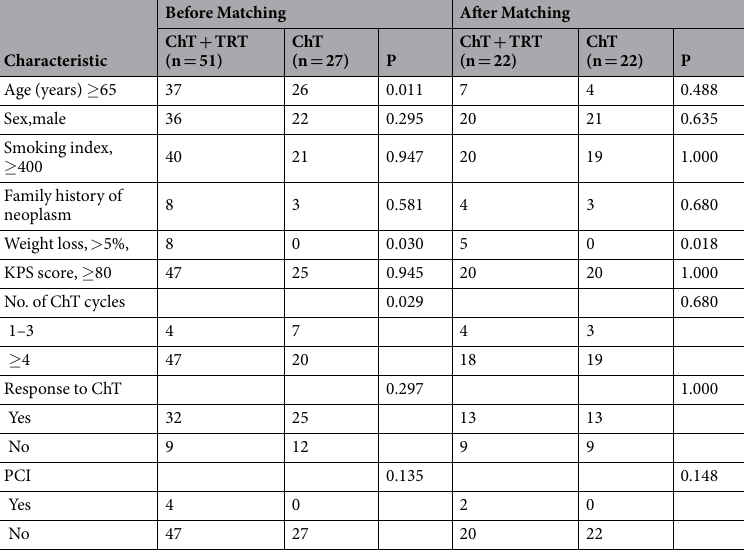
Table 3. Disease characteristics of patients with oligometastases with chemotherapy + thoracic radiotherapy vs. chemotherapy after Propensity Score